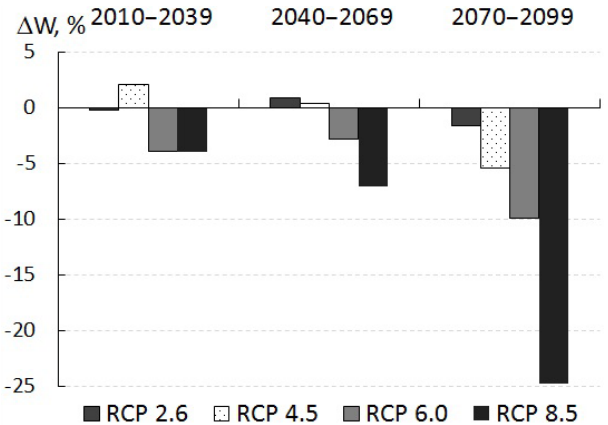
Figure 2. Results of evaluation ability of the GCM-driven regional hydrological model to simulate the observed mean annual runoff ( Q , m 3 s − 1 ) in the Selenga R. at Kabansk gage.